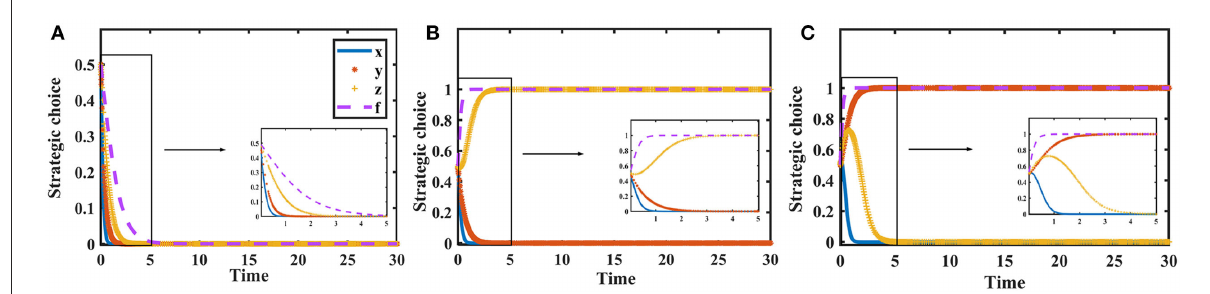
FIGURE6 Impact of penalties on the evolution of each player’s strategy. Figure is the simulation diagram that shows the influence of the penalties on the strategic choices of government regulator, pharmaceutical enterprises, medical institutions, and pharmaceutical e-commerce companies. (A) When F g = 0, F s = 0, F m = 0; (B) when F g = 4, F s = 6, F m = 4; (C) when F g = 10, F s = 10, F m = 10.